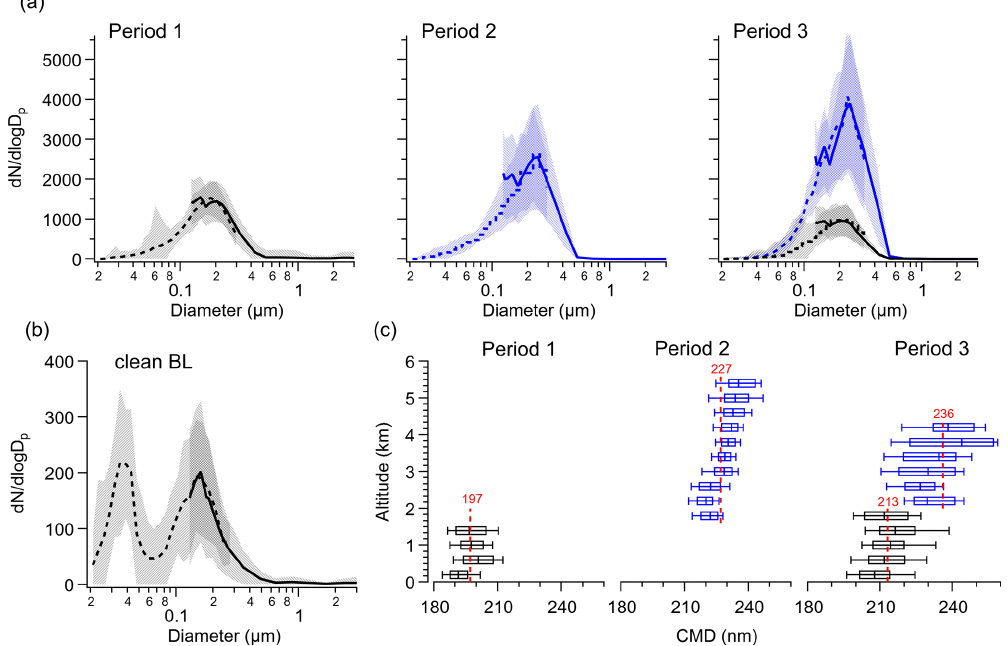
Figure 6. (a) The average size distributions of SLRs in the BB-polluted FT (blue) and BL (black) respectively for each period. The solid lines represent results from PCASP; dashed lines represent results from SMPS. The blue lines and shading show mean and standard deviation from the FT; the black lines represent the BL. (b) The average size distribution of SLRs in the clean BL. (c) The vertical distribution of lognormal fitted count median diameters (CMD) from the PCASP. The box-and-whisker plots indicate the 10th percentile, 25th percentile, median, 75th percentile and 90th percentile in every 400m bin in the BB-polluted FT (blue) and BL (black). The red dashed lines and numbers represent the lognormal fitted CMD of mean size distribution in the BB-polluted FT (blue) and BL (black) for each period.